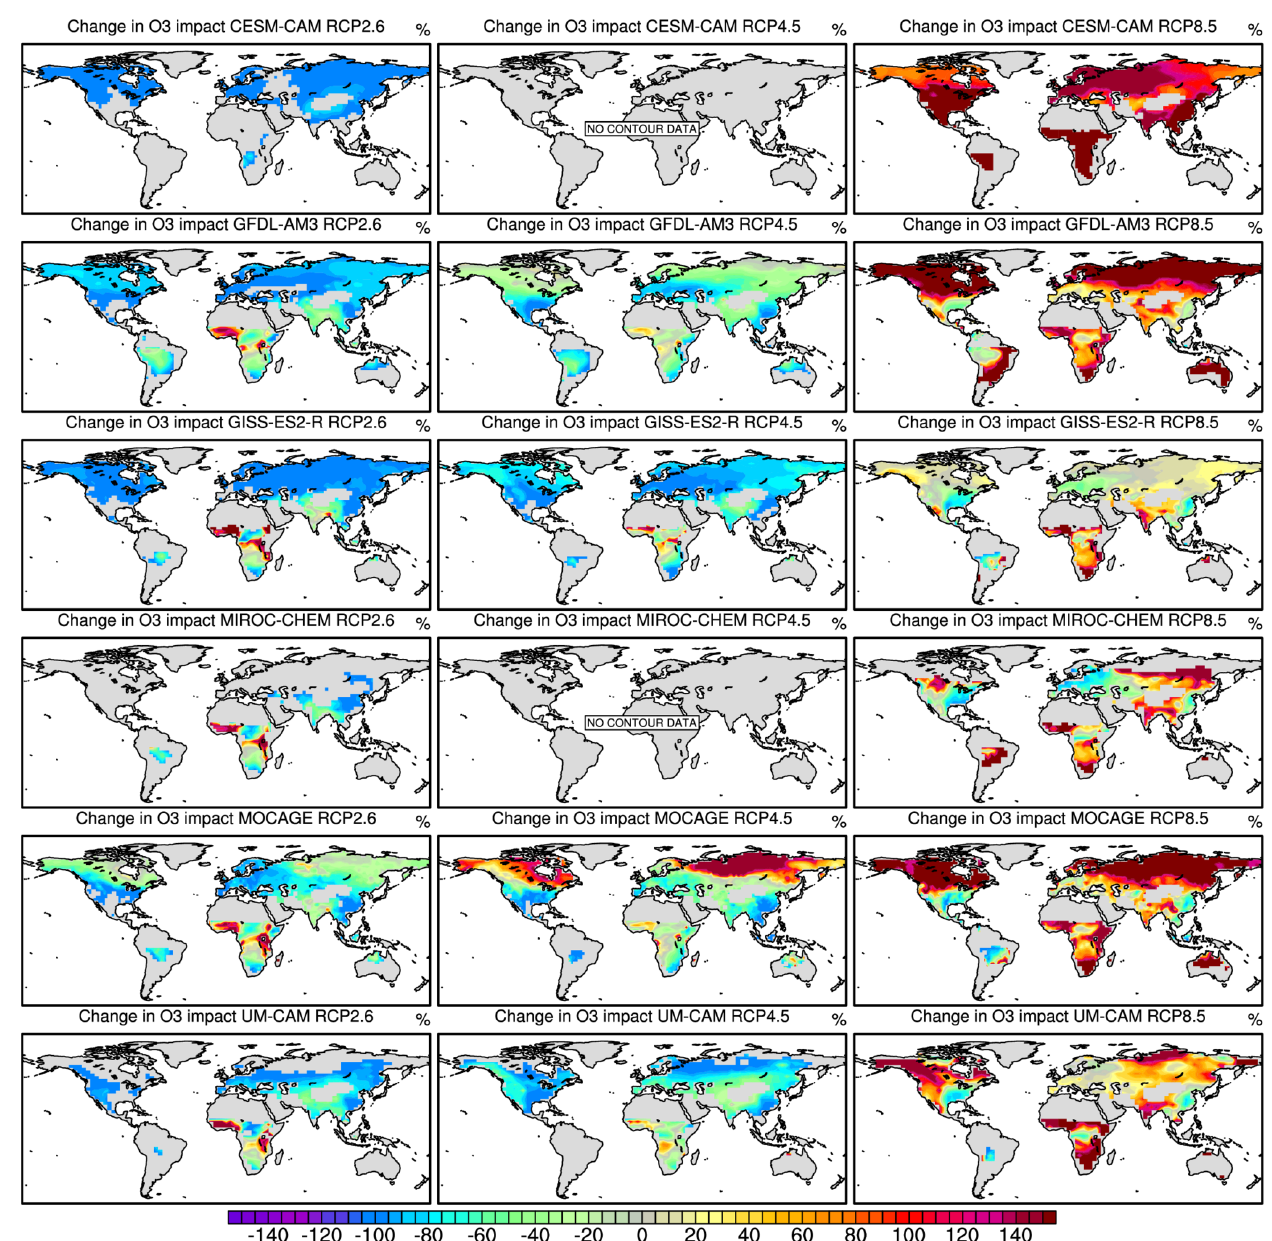
Figure 3. Simulated percentage changes (%) in the potential ozone impact on photosynthetic carbon assimilation (IO 3 ) for each ACCMIP model between RCP2.6, RCP4.5 and RCP8.5 simulations and the historical run. The data are missing for two models under RCP4.5 (“no contour